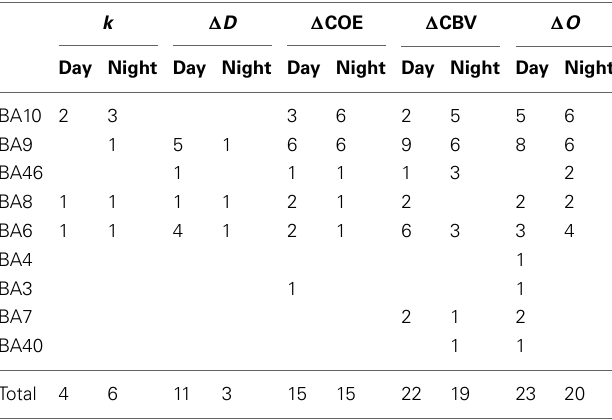
Table 5 | Number of channels showing positive correlations with the medial BA8 ( r > 0 .